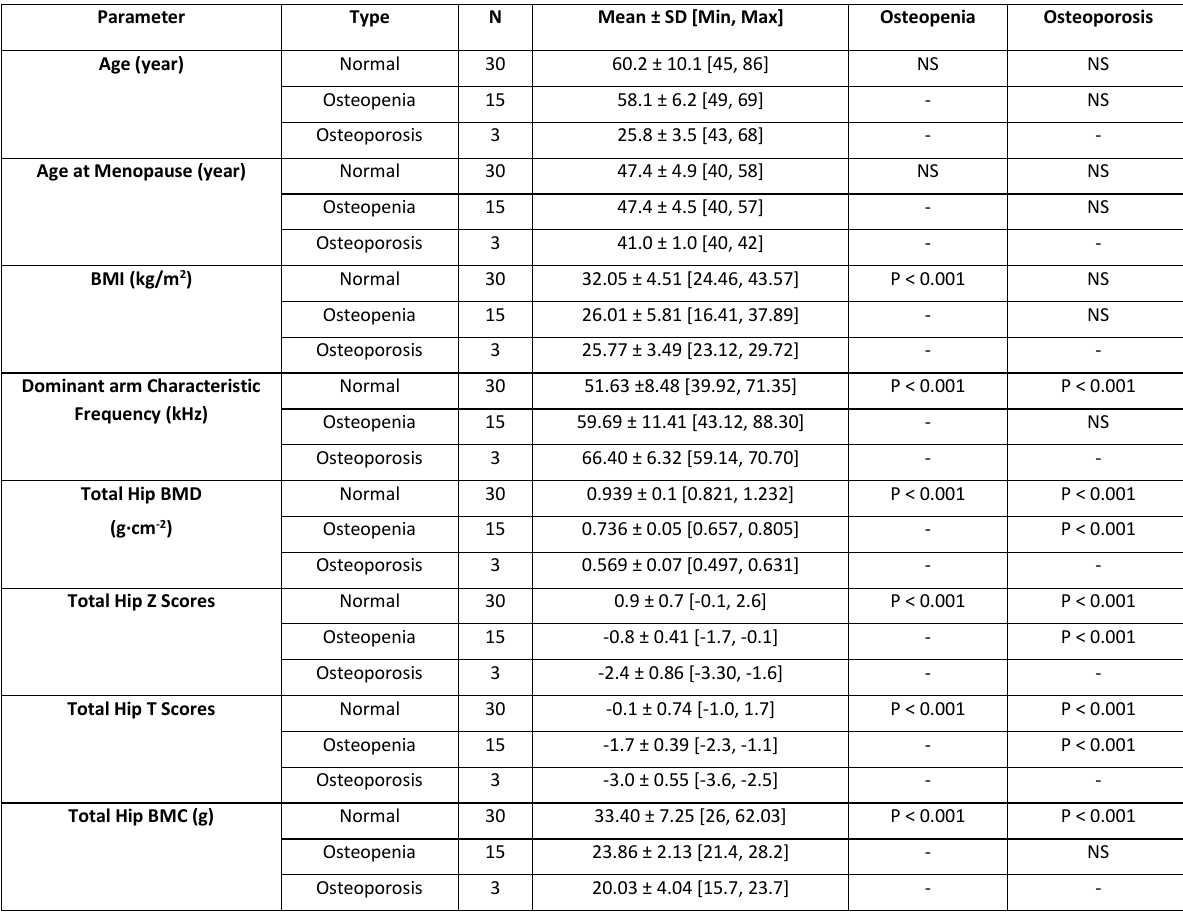
Table 2. The classification and statistical analysis of patients based on hip BMD values.